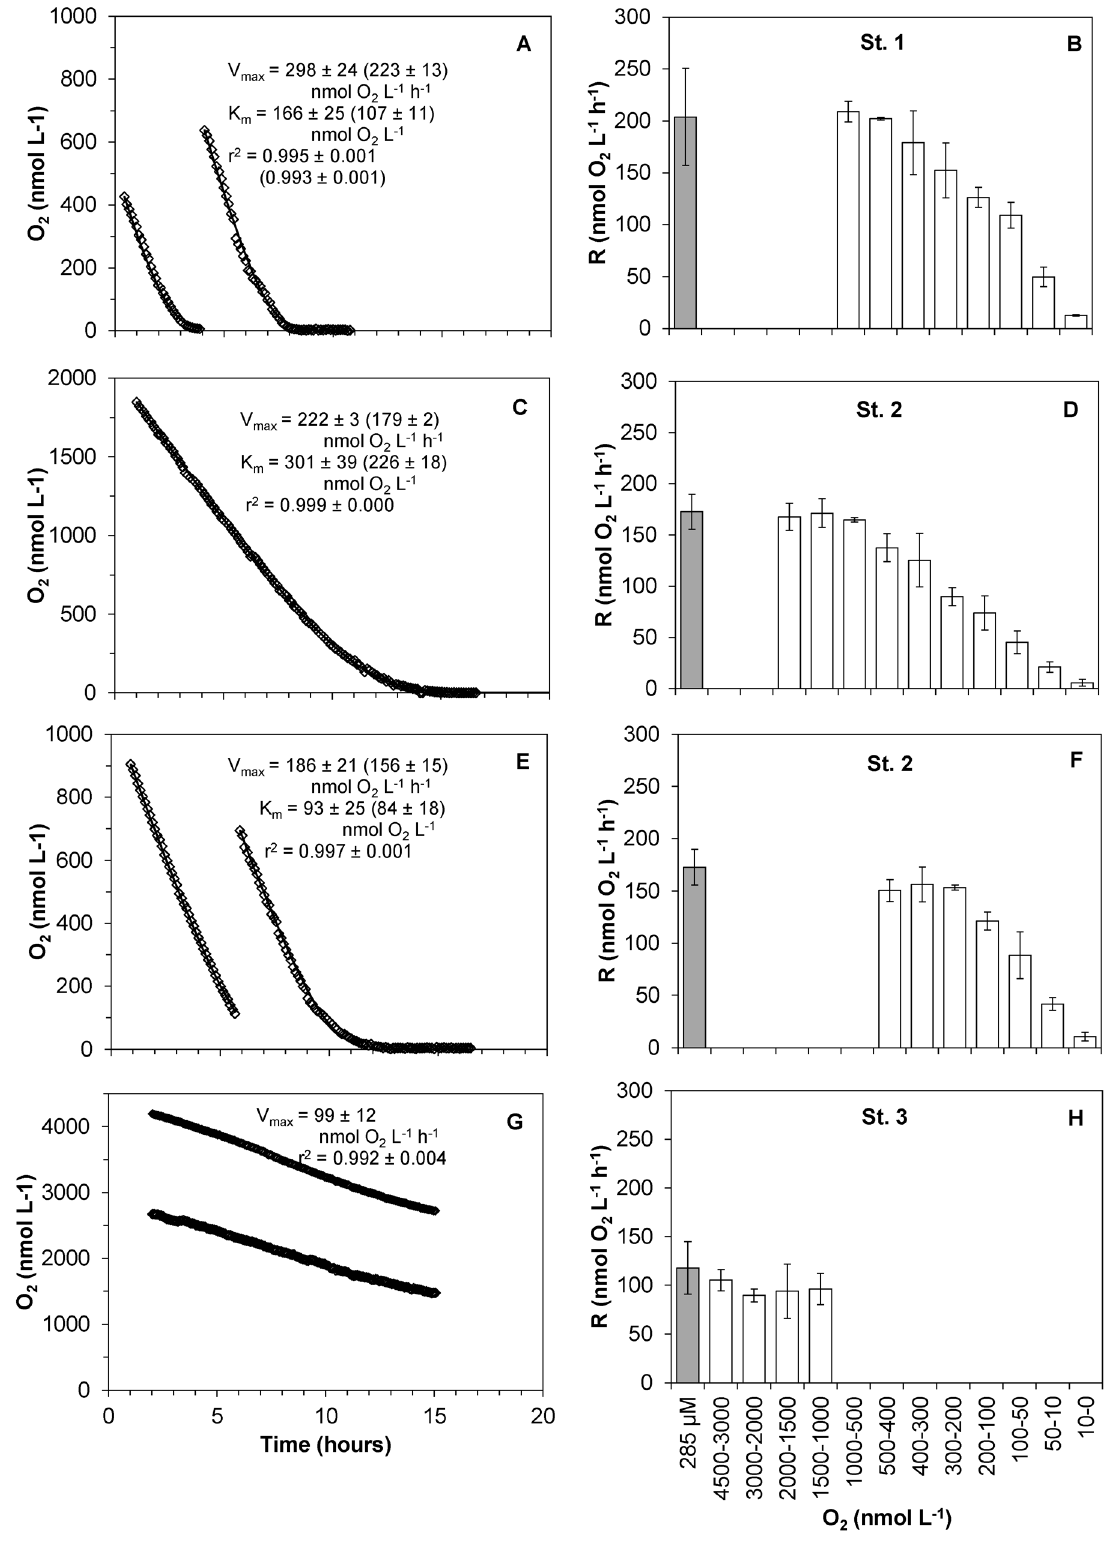
Figure 6. Comparison of CR rates measure with the STOX method and with Winkler titrations. Time course of oxygen depletion during incubations (A, C, E, G) and respiration rates at different O 2 concentrations (B, D, F, H) measured by the STOX method (from 0 to 2 m mol L 2 1 , white bars), and by Winkler titrations (at air saturation, grey bars). A, B: St. 1 (Randers Fjord); C, D: St. 2 (Marselisborg Marina) at concentrations of 0–2 m mol L 2 1 and E, F: Marselisborg Marina at concentrations of 0–1 m mol L 2 1 . G, H: St. 3 (Hanstholm). Rates are averages 6 standard error (n=3). Both Michaelis-Menten kinetic parameters and Jassby and Platt ones (in parenthesis) are presented. doi:10.1371/journal.pone.0105399.g006 PLOS ONE |